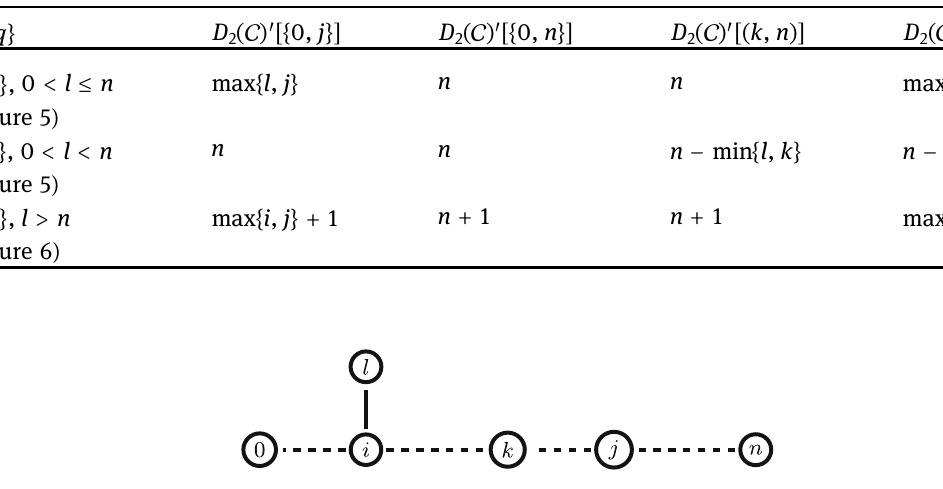
Figure 6: Minimum subgraph of C containing vertices {